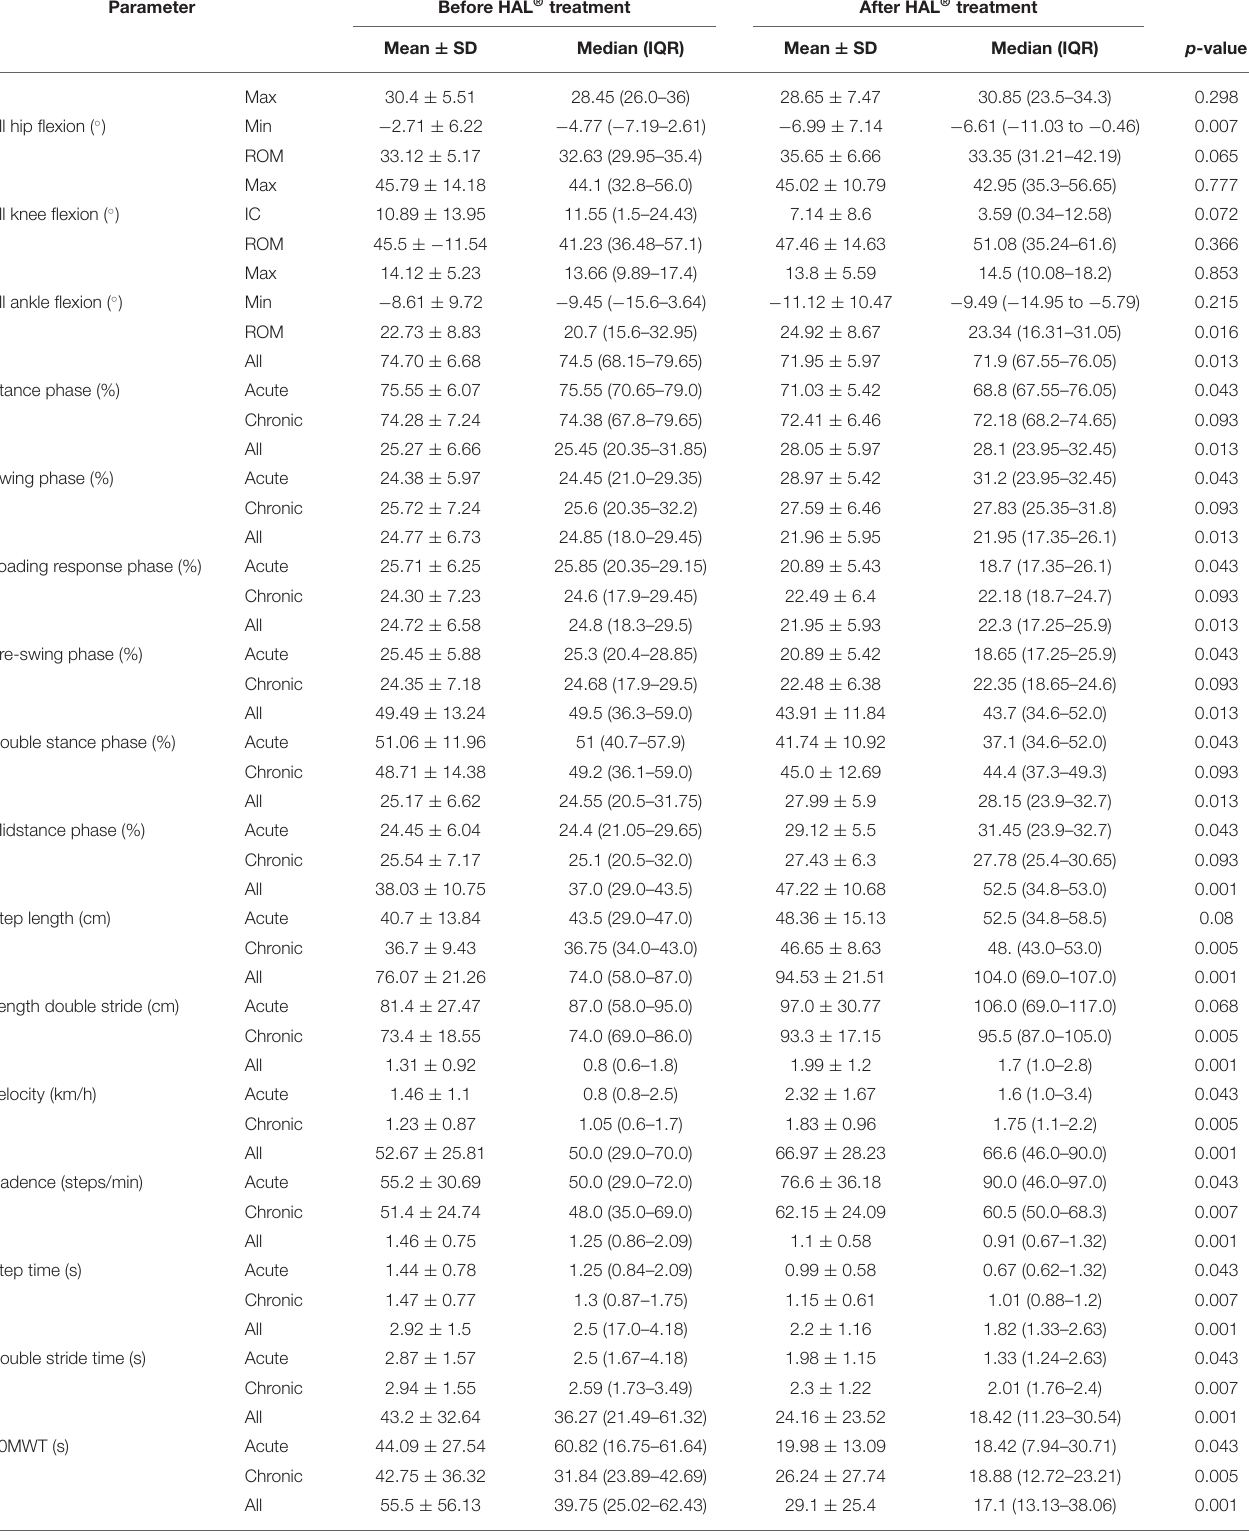
TABLE 2 | Measurement descriptives and statistical outcome.